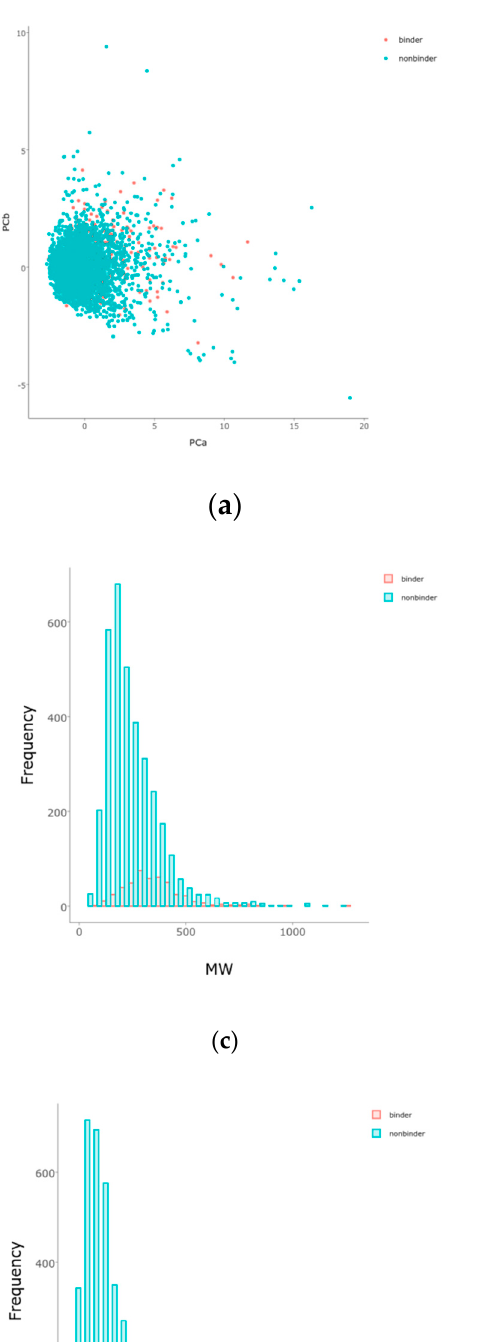
Figure 6. t-Maps for binders and nonbinders in the evaluation set. ( a ) clog P ; ( b ) TPSA (Å 2 ); ( c ) Number of heterocycles.